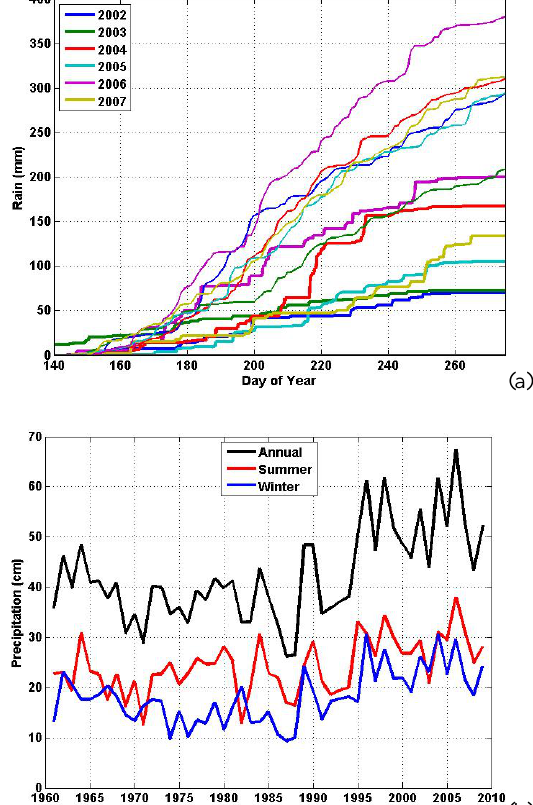
Fig. 2. Precipitation at Lake El’gygytgyn. In (a) , cumulative rainfall from the AWS tipping bucket (thick lines) and NNR (thick lines). The NNR fails to capture daily events, but does better in capturing annual trends, though 2–3 times higher in magnitude. In (b) , annual precipitation from NNR, showing that winter and summer magni- tudes are roughly equal, and dry in